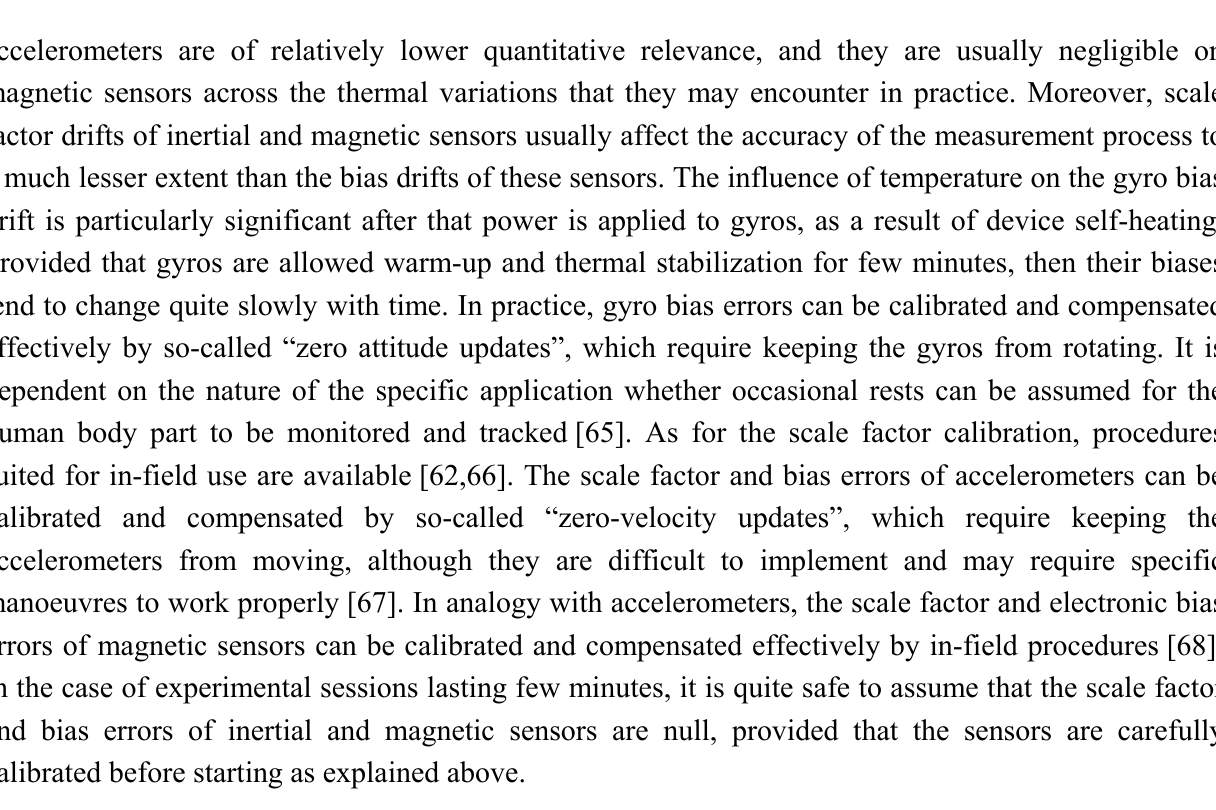
Figure 5. A single-axis accelerometer measures the projection (in the direction of the sensitive axis) of the specific force f resulting from the sum of the inertial acceleration a and the equivalent gravity acceleration – g